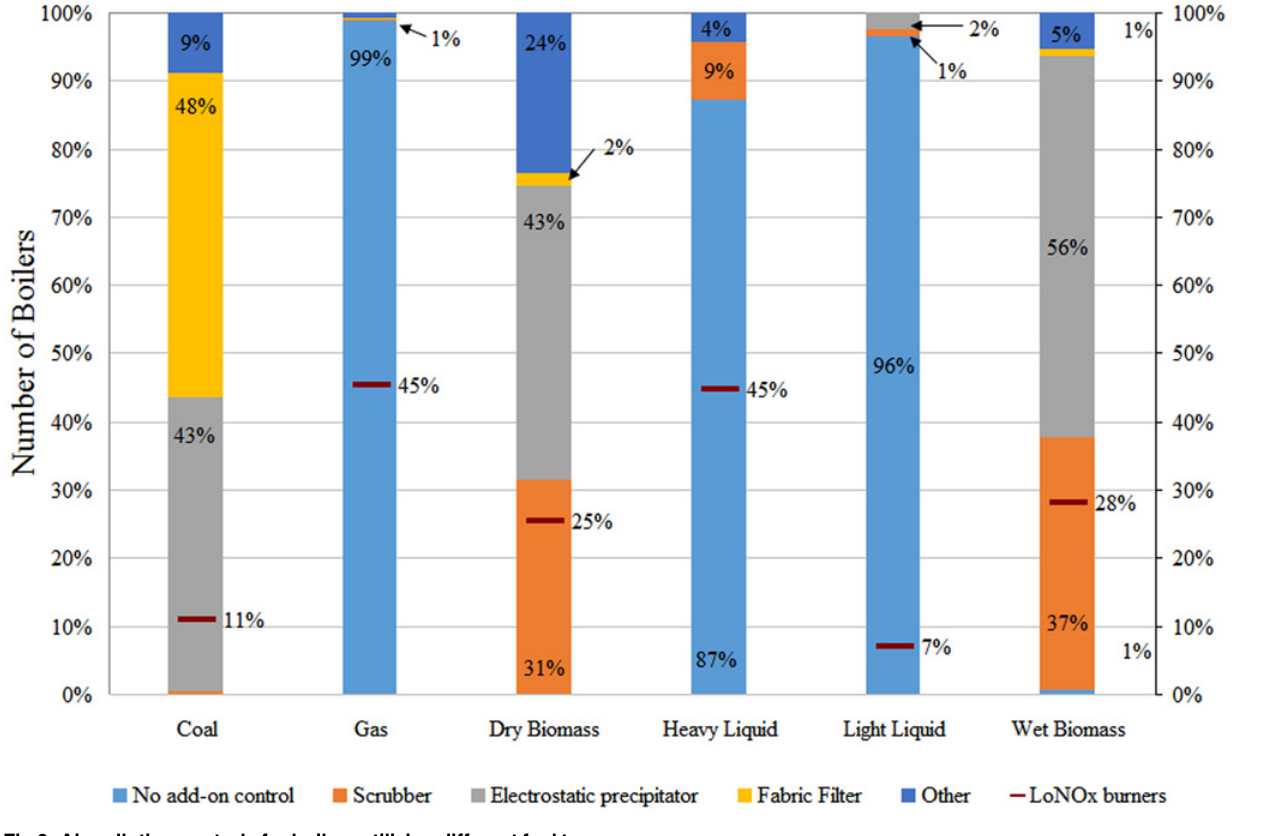
Fig 6. Air pollution controls for boilers utilizing different fuel types.